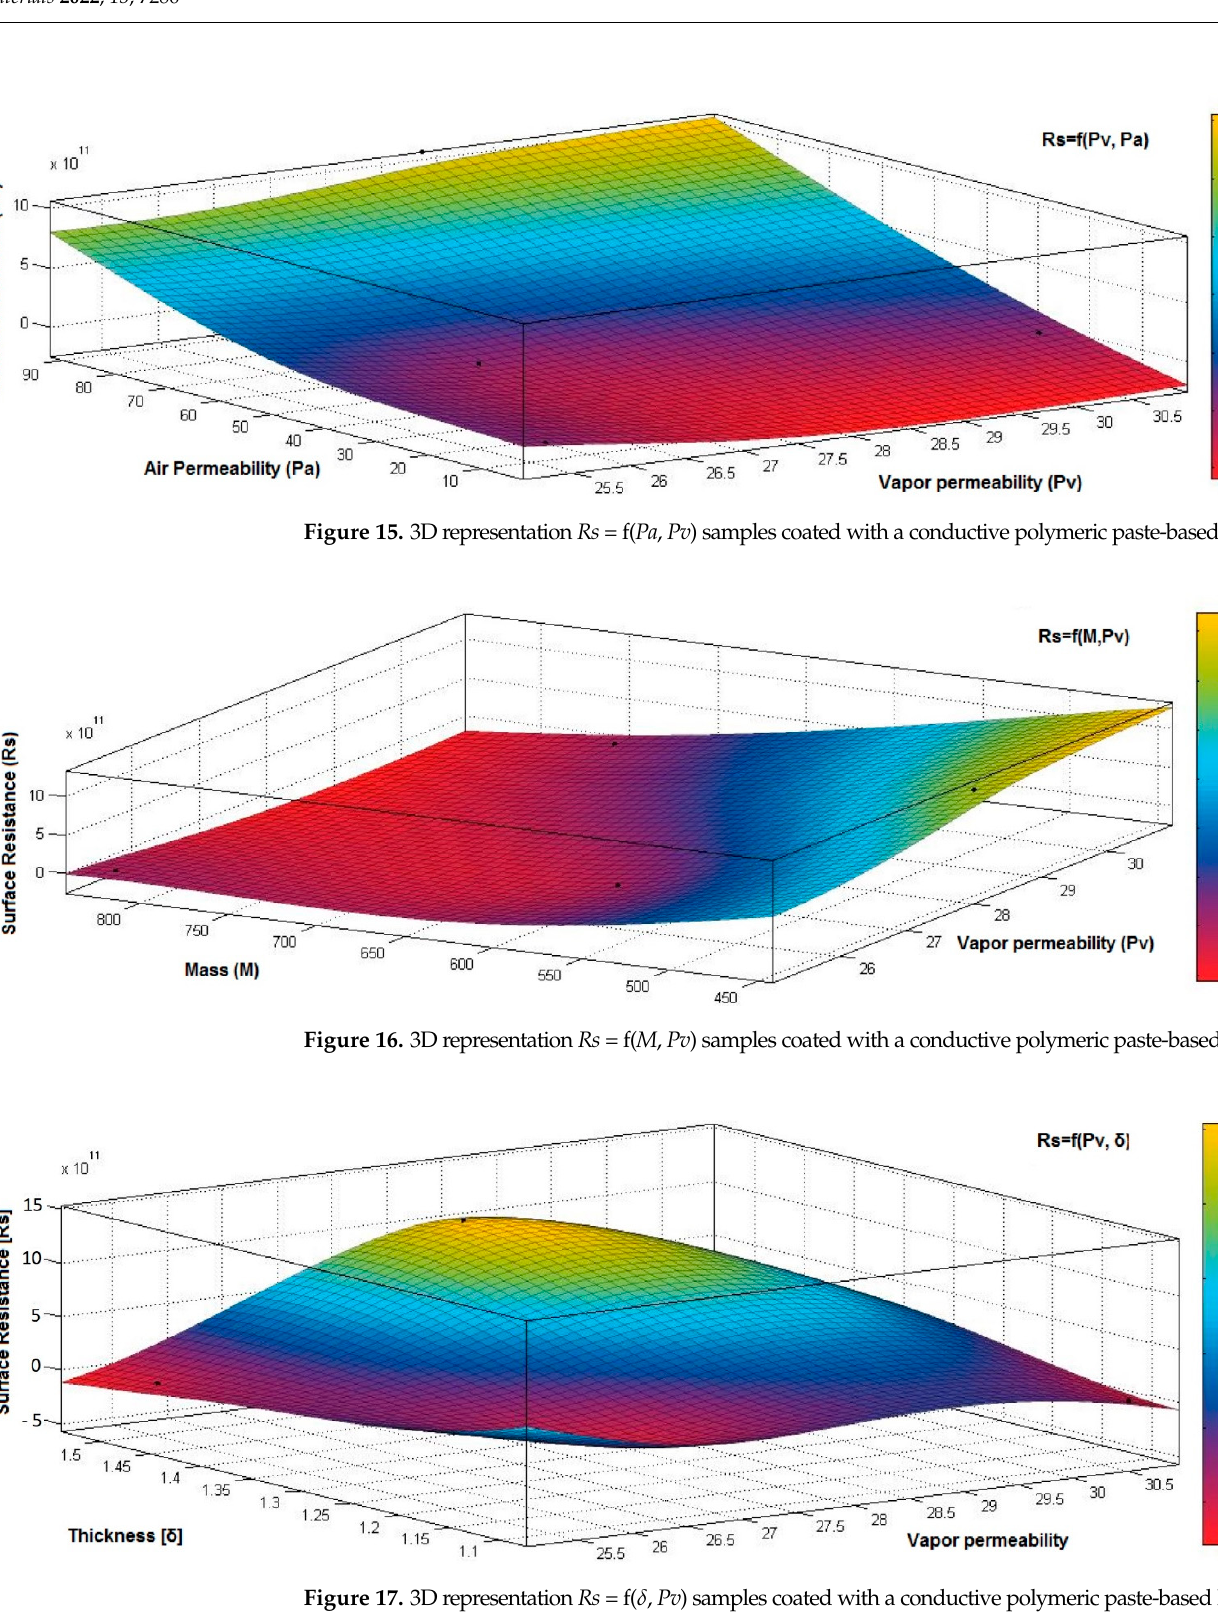
Figure 18. 3D representation Rs = f( δ , Pa ) samples coated with a conductive polymeric paste ‐ based PVDF. Figure 19 presents the 3D representation of the electrical surface resistance ( Rs ) de ‐ pending on the mass ( M ) and air permeability ( Pa ). Figure 19. 3D representation Rs = f (M , Pa) samples coated with a conductive polymeric paste ‐ based PVDF.